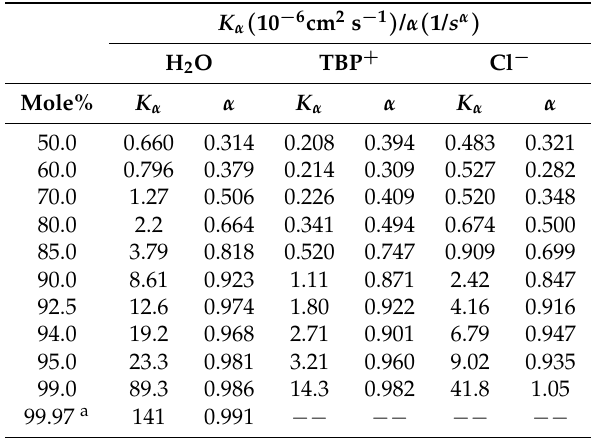
Figure A7. Ergodicity breaking parameter ( χ ) in TBPCl–water at p = 1atm and T = 300K as a function of water concentration and lag time for [34]: ( a ) Cl − ; ( b ) water; ( c ) TBP + . Table A1. TBPCl anomalous diffusion coefficients of water, TBP + , and Cl –